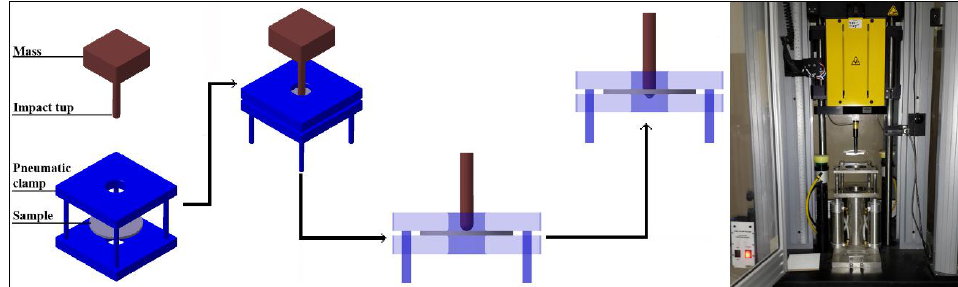
Figure 4. The schematic representation of the drop weight impact test, and, in addition, the used